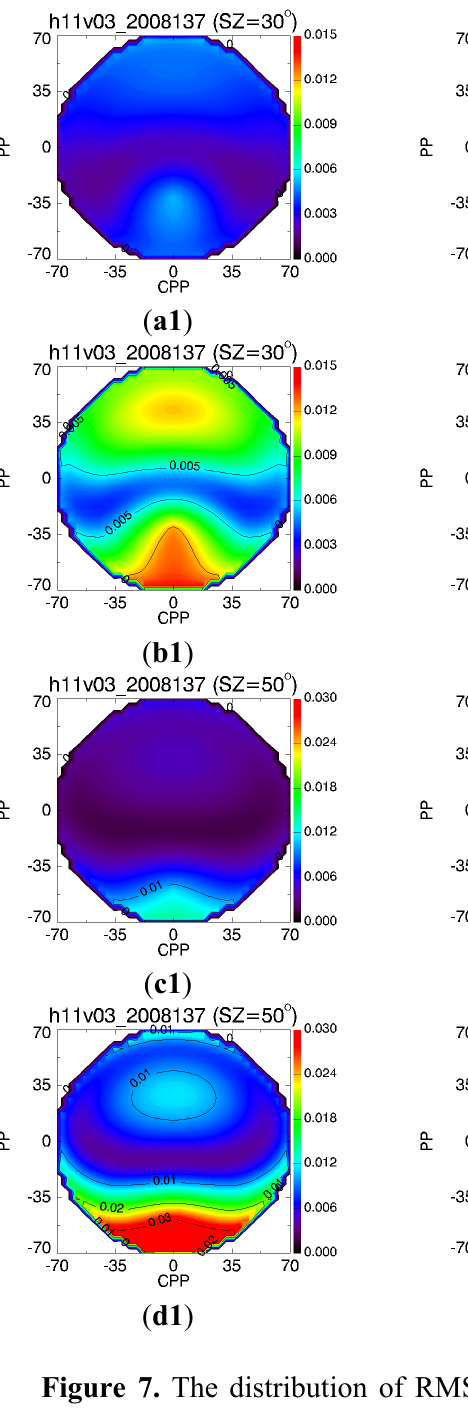
Figure 7. The distribution of RMSEs between the directional reflectance of the MODIS BRDF and the BRDF archetype inversion for the entire viewing hemisphere using MODIS multi-angular observations of tiles H11V03 (1st column, year 2008, day 137), H08V05 (2nd column, day 49) and H20V11 (3rd column, day 249). The solar zenith angles are ( a , b ) 30° and ( c , d ) 50° for the (a, c) red and (b, d) NIR bands. The zero zenith angle is in the centre, the radius represents the zenith angle, and the polar angle represents the azimuth angle. The contours and colors represent the values of the